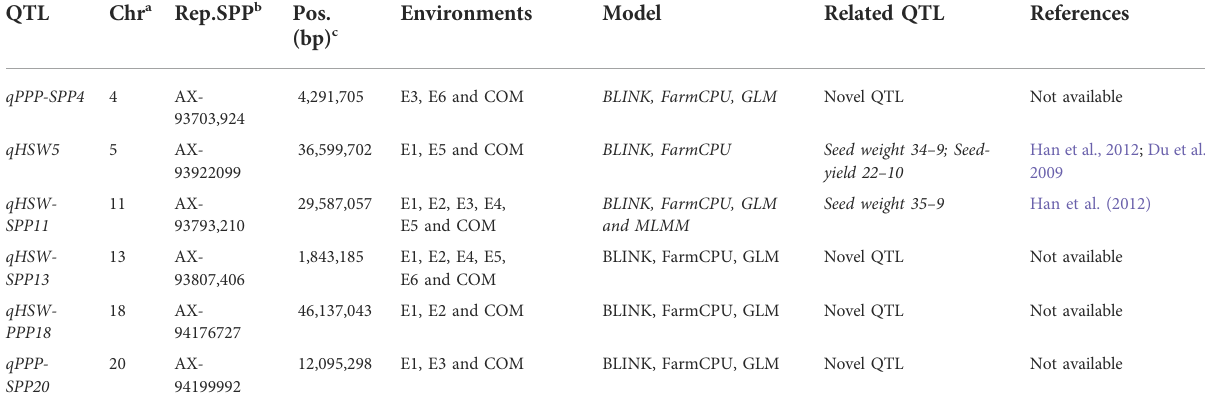
TABLE 3 Stable QTLs/genomic regions identi fi ed for the studied traits in at least three or more environments.